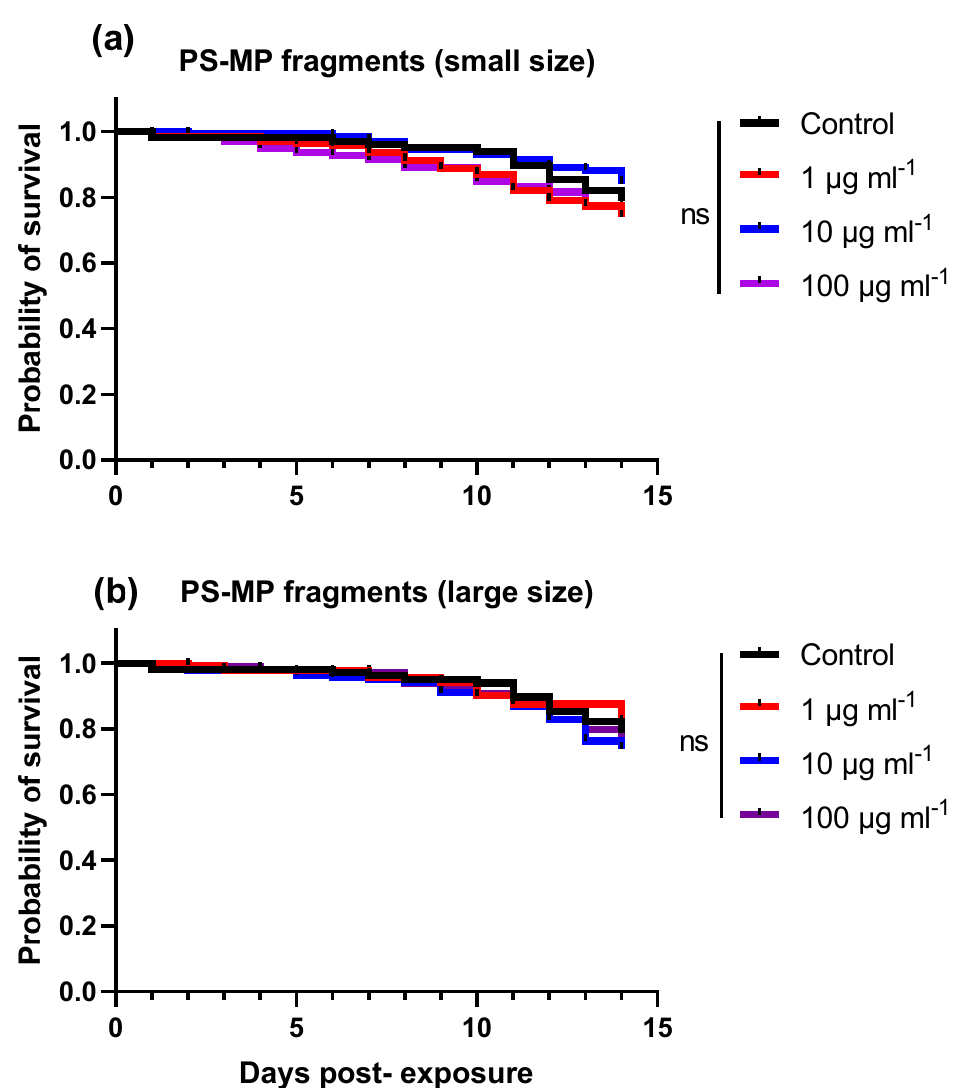
Figure 3. Kaplan–Meier survival curves of honey bees fed sugar syrup containing PS-MP fragments at various concentrations for 14 days. Bees ( n = 35 bees per cage, n = four cages per treatment) were fed ad libitum with various concentrations (1, 10, 100 µ g mL − 1 ) of either ( a ) small sized (27 ± 17 µ m) or ( b ) large sized (93 ± 25 µ m) PS-MP fragments. Controls received the same treatments devoid of PS-MP fragments. There were no significant differences between treatments (log-rank (Mantel–Cox), p > 0.05).